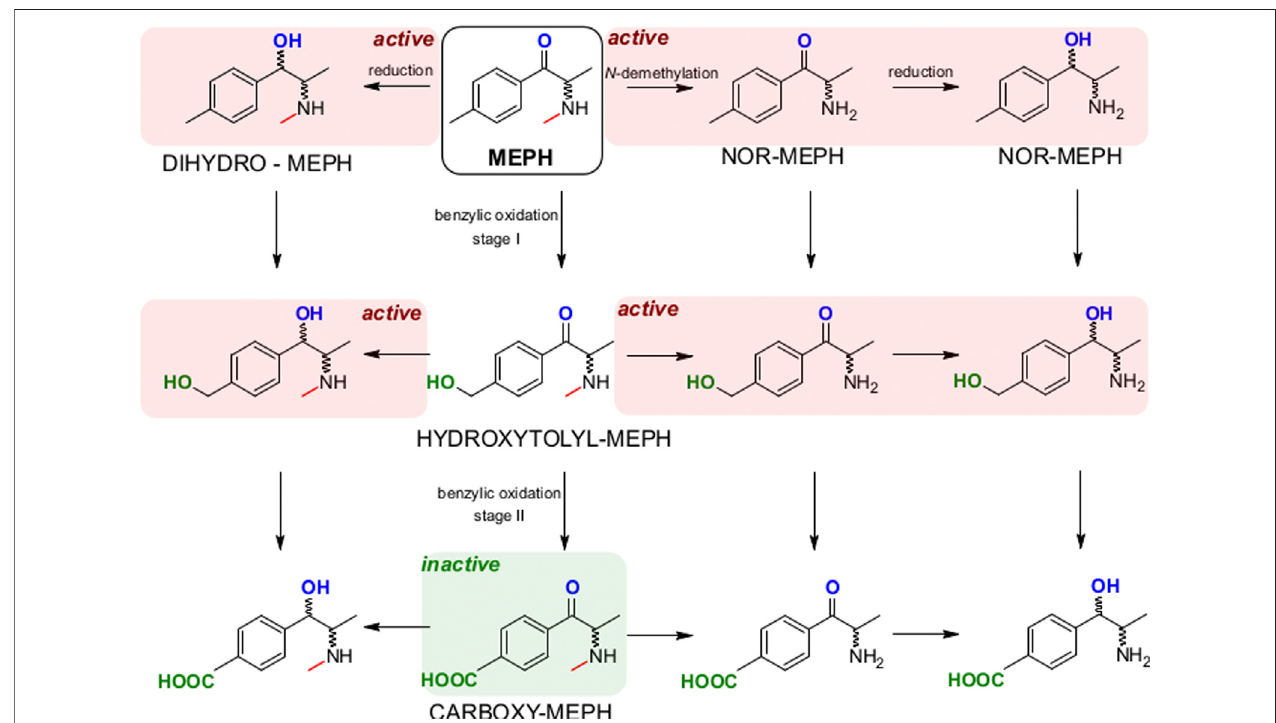
FIGURE 7 | Model of MEPH metabolism with the pathways leading to still active or inactive metabolites. N-demethylation and reduction lead to active metabolites (redbackground)whicharestillactiveatDATandNET.Instead,thebenzylicoxidationleadstothecarboxy-MEPH(4-COOH-MC,greenbackground)whichisinactiveat DAT, NET and